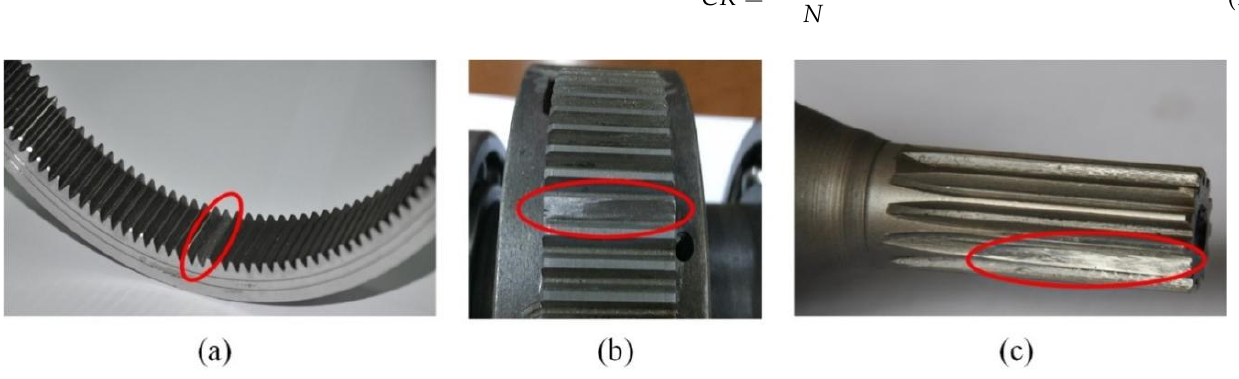
Figure 6. Schematic diagram of gear preset fault: ( a ) ring gear fault; ( b ) planet gear fault; ( c ) sun gear fault. Table 1. Four preset fault datasets under different working conditions.